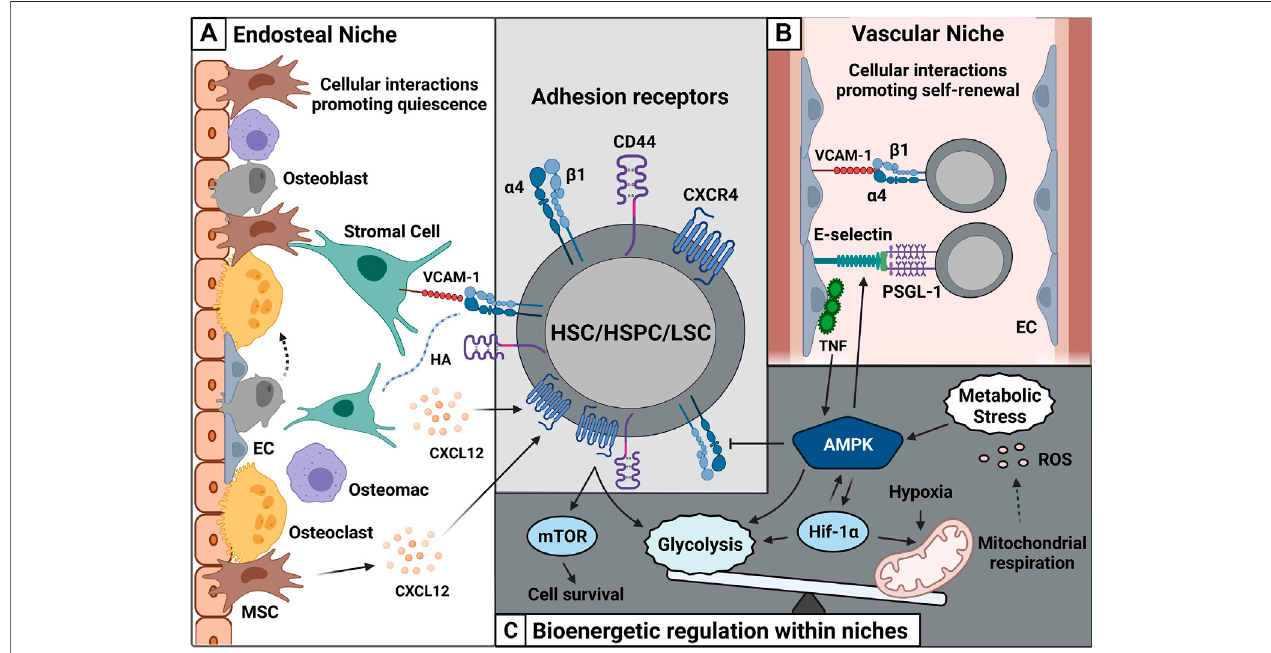
FIGURE 1 | Cell-cell interactions within the BM microenvironment are shaped by adhesion and metabolism. (A) HSC/HSPC/LSC express adhesion receptors such as α 4 β 1, CD44, and CXCR4. These receptors interact with their speci fi c ligands such as VCAM-1, HA, and CXCL12 on non-hematopoietic cells such as stromal cells, MSCs and osteoblasts and contribute HSC quiescence. (B) The vascular niche made up of sinusoids contains numerous ECs. These ECs express large amounts of E-selectin and VCAM-1 and promote HSC/HSPC/LSC self-renewal. (C) Enhanced CXCR4-CD44 cooperativity can promote leukemic cell survival via mTOR and elevates glycolytic in fl ux. Metabolic stress further increases AMPK activity promoting glycolysis and Hif-1 α expression. High amounts of Hif-1 α create a hypoxic environment followed by release of ROS. Abbreviations: HSC/HSPC, hematopoietic stem cell/ hematopoietic stem and progenitor cell; LSC, leukemic stem cell; MSC, mesenchymal stem cell; EC, endothelial cell; VCAM-1, vascular cell-adhesion molecule-1; HA, hyaluronic acid; CXCL12, C-X-C Motif Chemokine Ligand 12; PSGL-1, P-selectin glycoprotein ligand-1; CXCR4, CXC receptor 4; mTOR, mammalian target of rapamycin complex; AMPK, adenosine-5 ′ -monophosphate-activated protein kinase; Hif-1 α , hypoxia-inducible factor α ; ROS, reactive oxygen species.